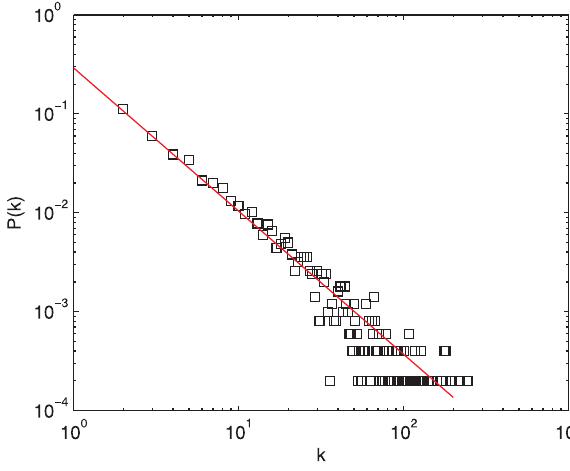
Figure 8. Gini coefficient for the distribution of participants in each cluster and in each post of our model as a function of time, N ~ 5000 , l ~ 0 : 001 , d ~ 0 : 5 . The Gini coefficient for posts’ participants remains relatively stable after a rapid increase, but the coefficient for clusters’ participants obviously decreases with the time elapsed.